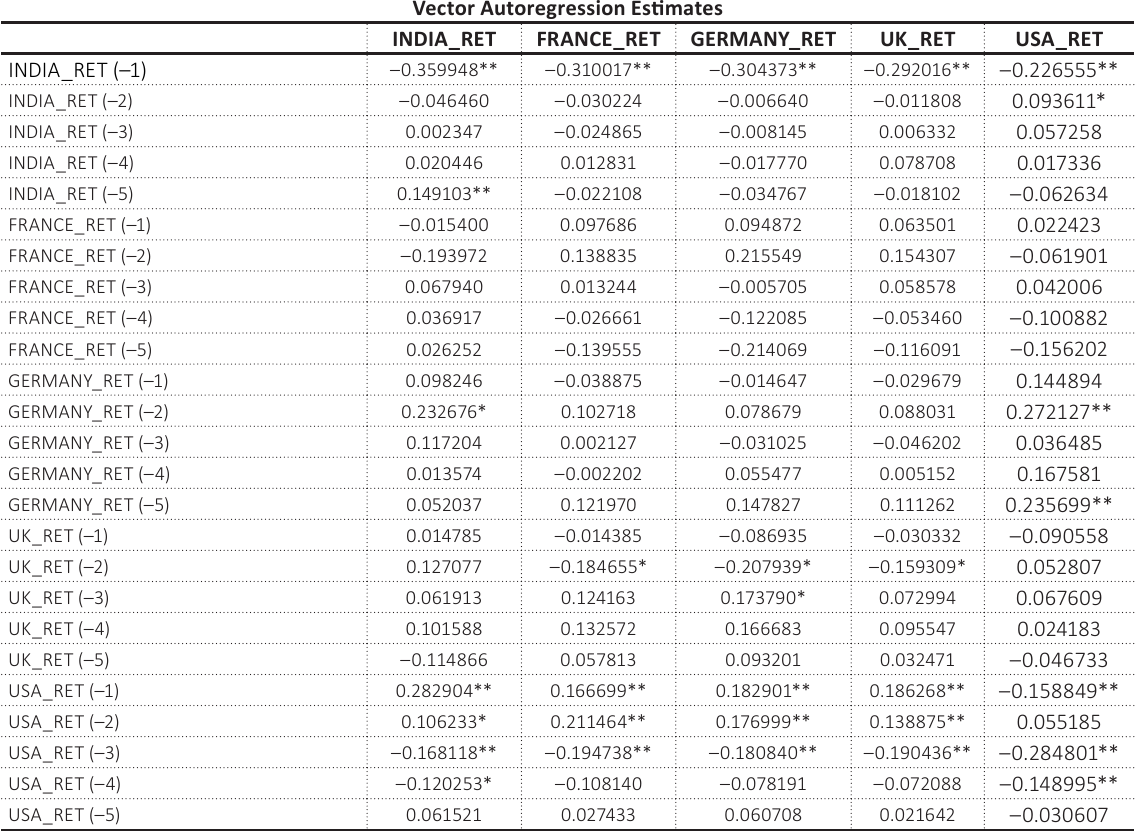
Table 4. Post-Brexit referendum period, VAR model Vector Autoregression